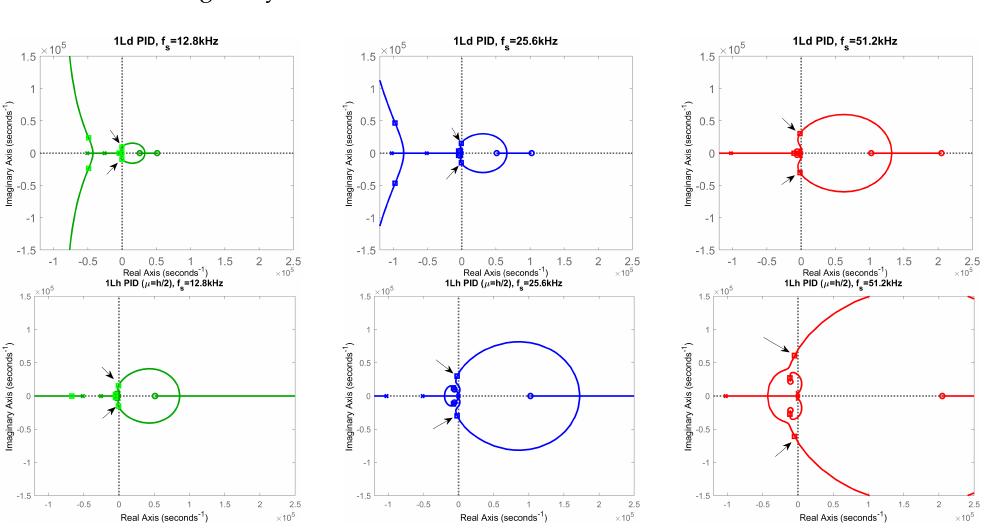
Figure 22. Root loci of 1L PID hybrid and digital control systems for different values of f s . The top row is for 1Lh (PID), the ( bottom ) row for 1Ld (PID). From ( left ) to ( right ), f s takes ascending values of 12.8 kHz, 25.6 kHz, and 51.2 kHz. The dominant roots are indicated by